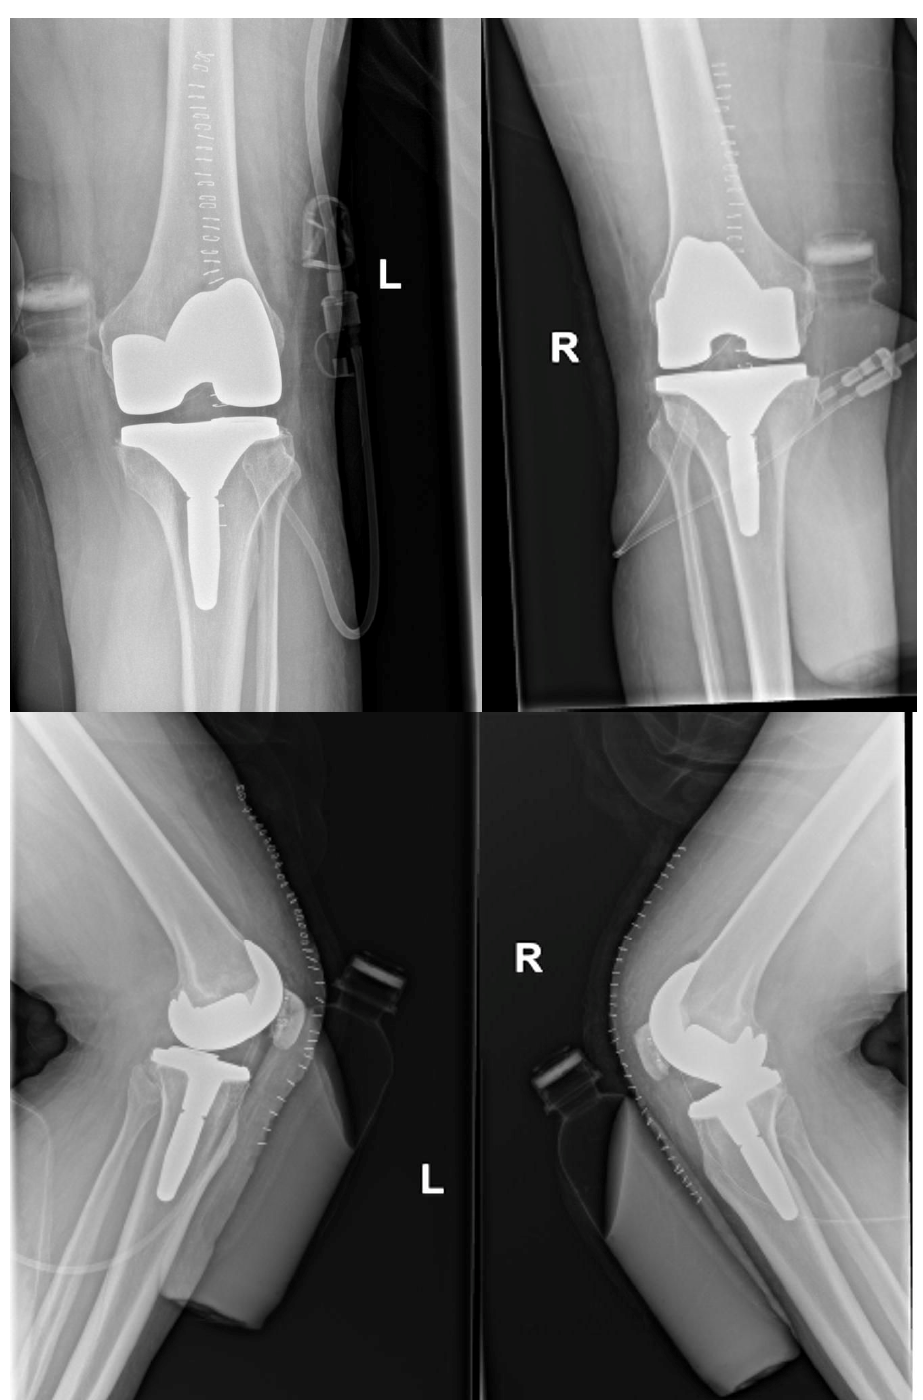
Figure 2. Showing postoperative knee joint in anterior-posterior and lateral views .